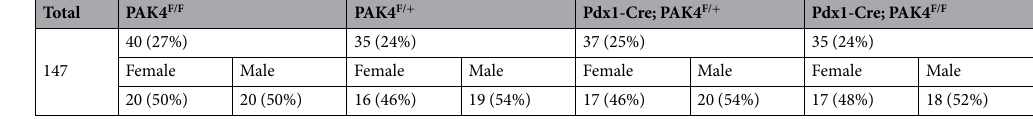
Table 1. Genotypes of the progeny from Pdx1-Cre; PAK4 F/ + × PAK4 F/F